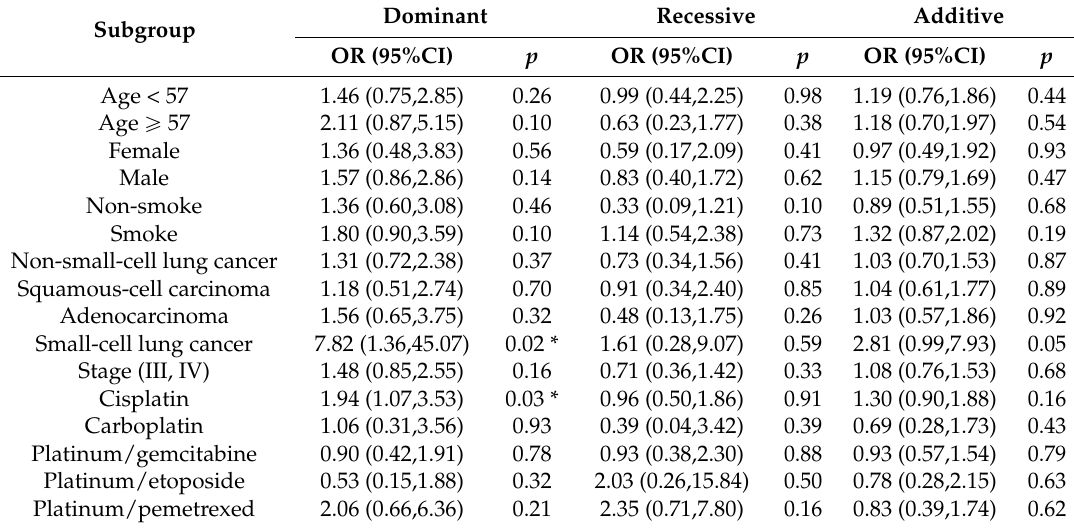
Table 11. Stratification analysis of relationship between CASC8 rs10505477 and gastrointestinal toxicity induced by platinum-based chemotherapy in lung cancers.